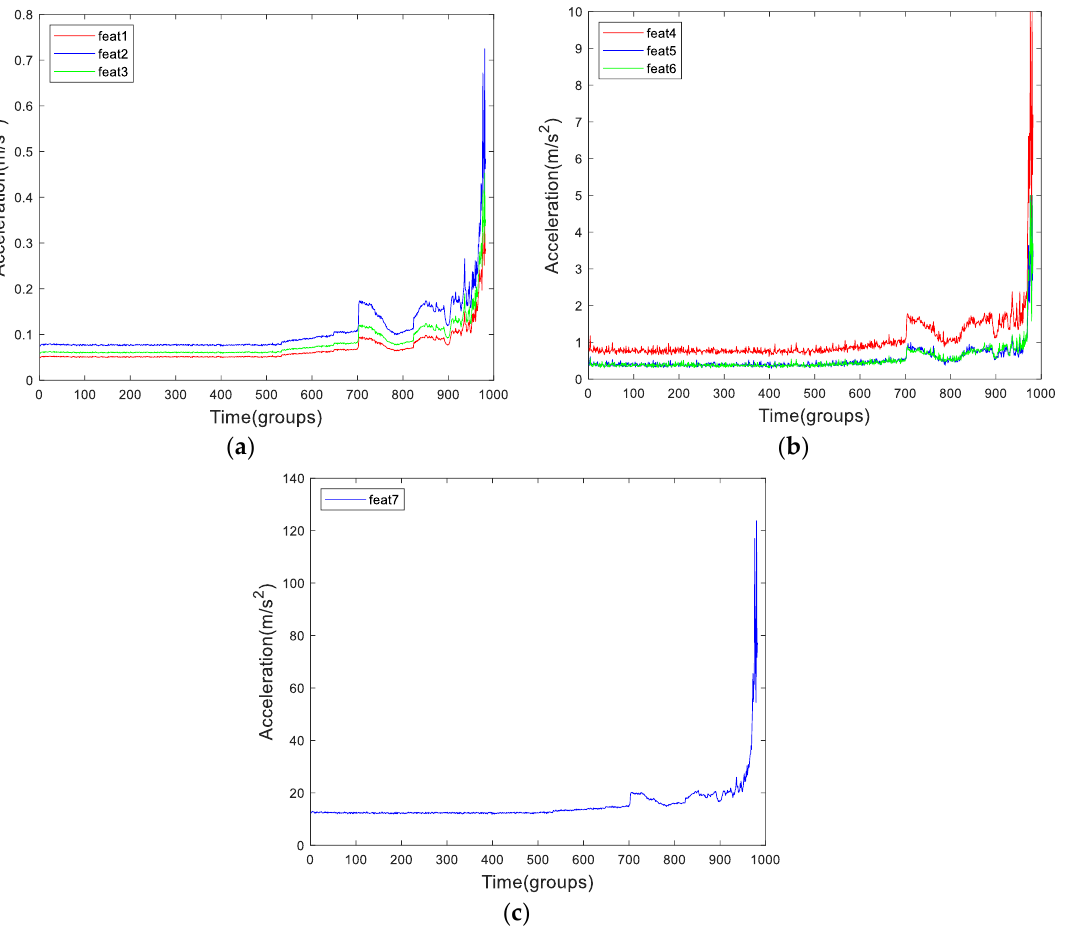
Figure 5. The curves of feat1 to feat7 of Bearing2-1IMS. ( a ) feat1 to feat3, ( b ) feat4 to feat6, ( c ) feat7.